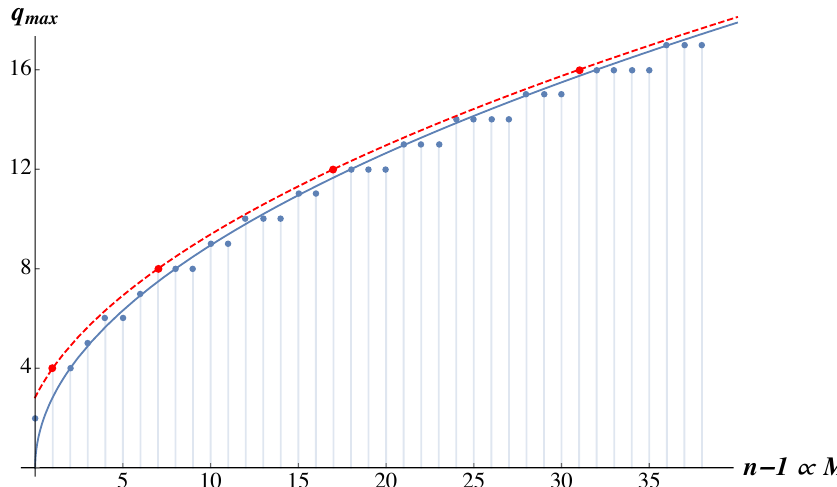
Figure 1 . Maximal charge q max ( n ) per excitation level n for a 6d F-theory compacti(cid:12)cation on Y 3 with base B 2 = F 1 . The model refers to the values (x ; y) = (4 ; 4) in the notation of section 4.1, p and has charge index m = 1 C (cid:1) C 0 = 2. The solid blue curve is given by q ( n ) = 4 m ( n (cid:0) 1), which 2 corresponds to the modi(cid:12)ed, scalar weak gravity bound derived in ref. [83] for the relevant extremal black holes. Observe that the charges for some excitations lie just barely above this curve, as a consequence of the plateau pattern in conjunction with the o(cid:11)set of the vacuum energy by (cid:0) 1. The p maximally superextremal states, marked in red, lie on the dashed curve given by q max ( n ) = 4 mn and populate a charge sublattice with spacing given by (cid:1) q = 2 m = 4. Together with the additional superextremal states lying between the red and the blue curves they populate the full charge lattice. This is a feature of this particular